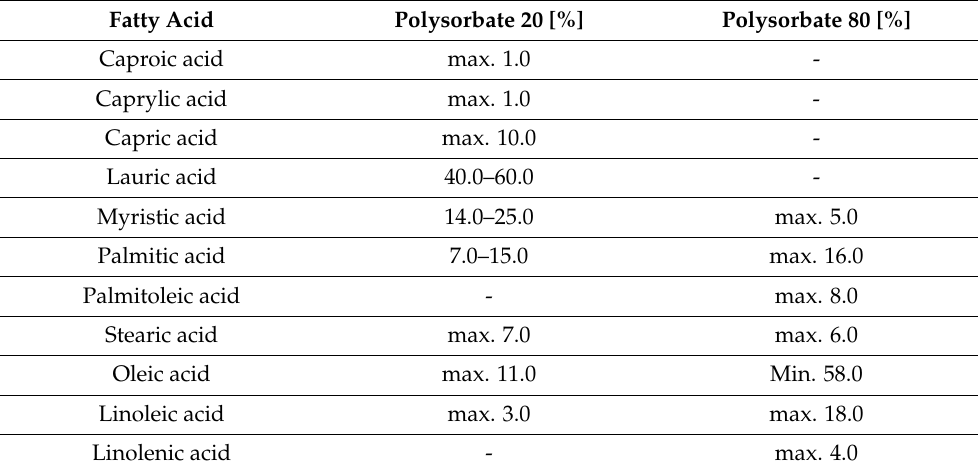
Table 1. Type and content of the fatty acids present in PS20 and PS80 raw material